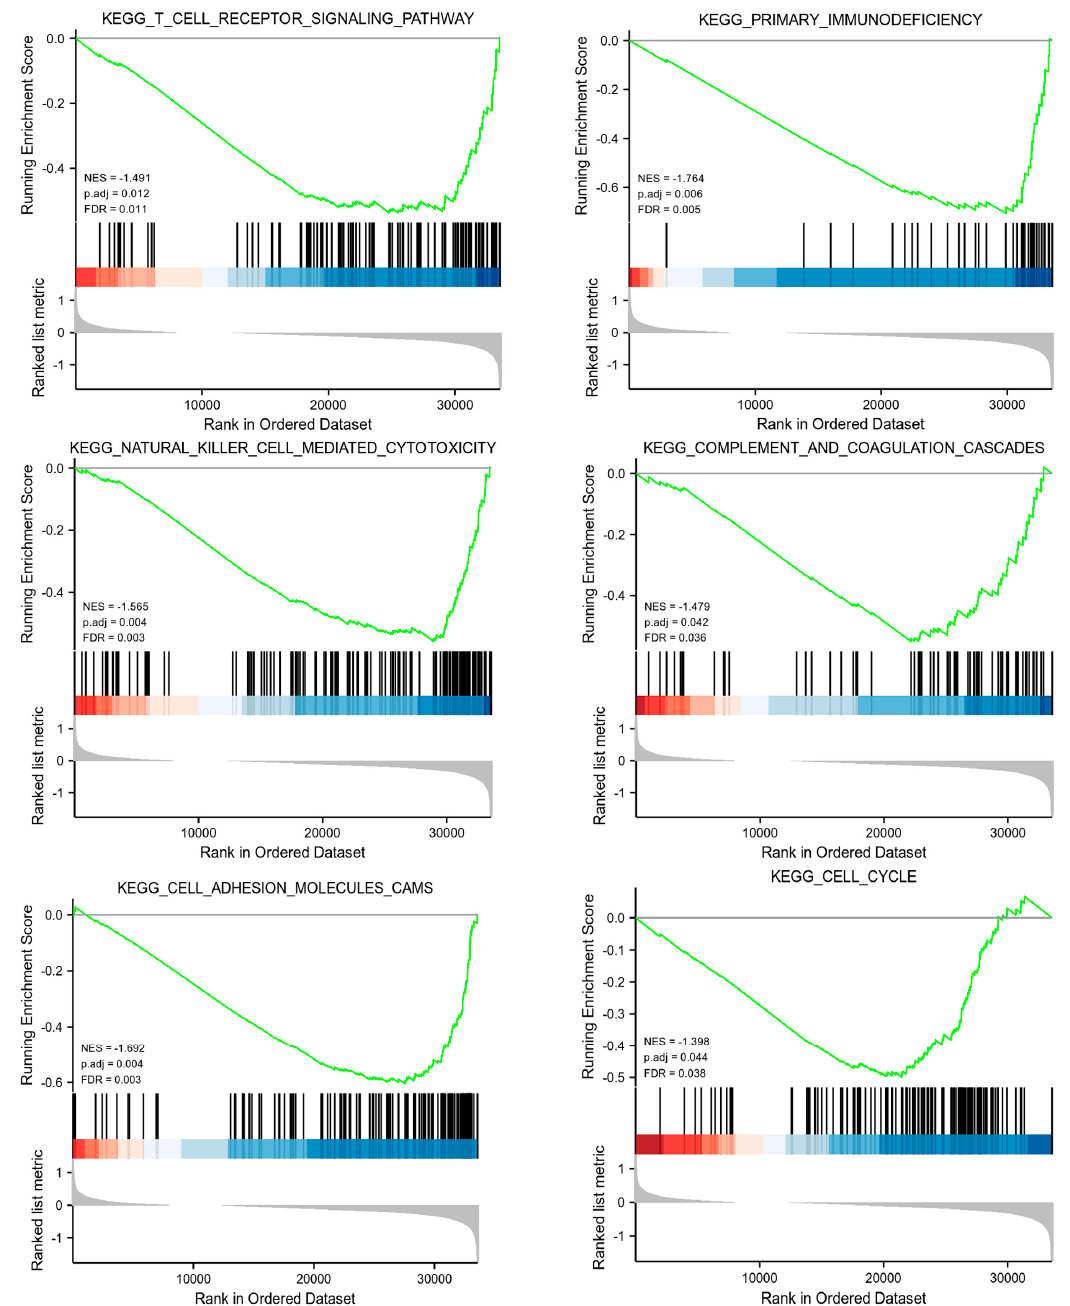
Figure 7. Gene set enrichment analysis (GSEA) for model long non-coding RNAs (lncRNAs). NES, normalized enrichment score; FDR, false discovery